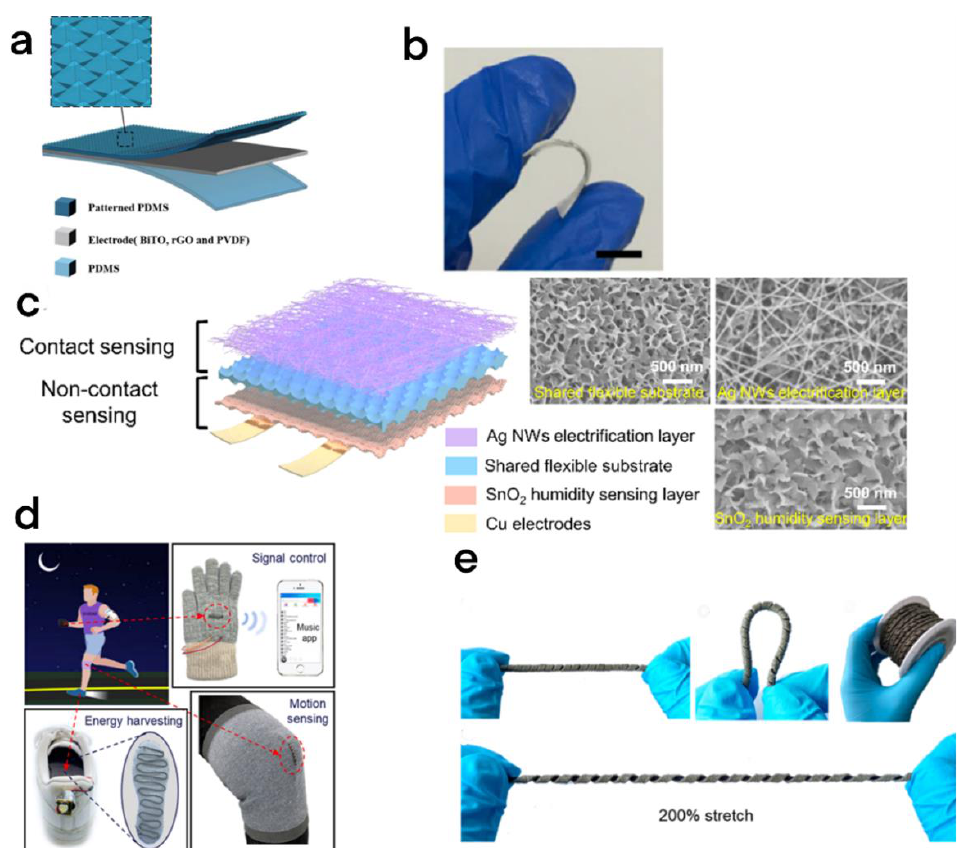
Figure 8. ( a ) Schematic representation of the basic structure of the tactile electronic skin. Flexible electronic textiles based on TENGs. ( b ) Electronic skin bending test [65]. Rao et al. (2020), Elsevier. ( c ) CNE schematic and SEM images for contact and noncontact sensing capabilities [66]. Yin et al. (2022), Elsevier. ( d ) Applications of sensors based on HS-TENG in signal control, body feeling, and energy collection. ( e ) Photos of the flexible HS-TENG, which can be bent and stretched to 200% tensile strain [67]. Wu et al. (2022), Elsevier.